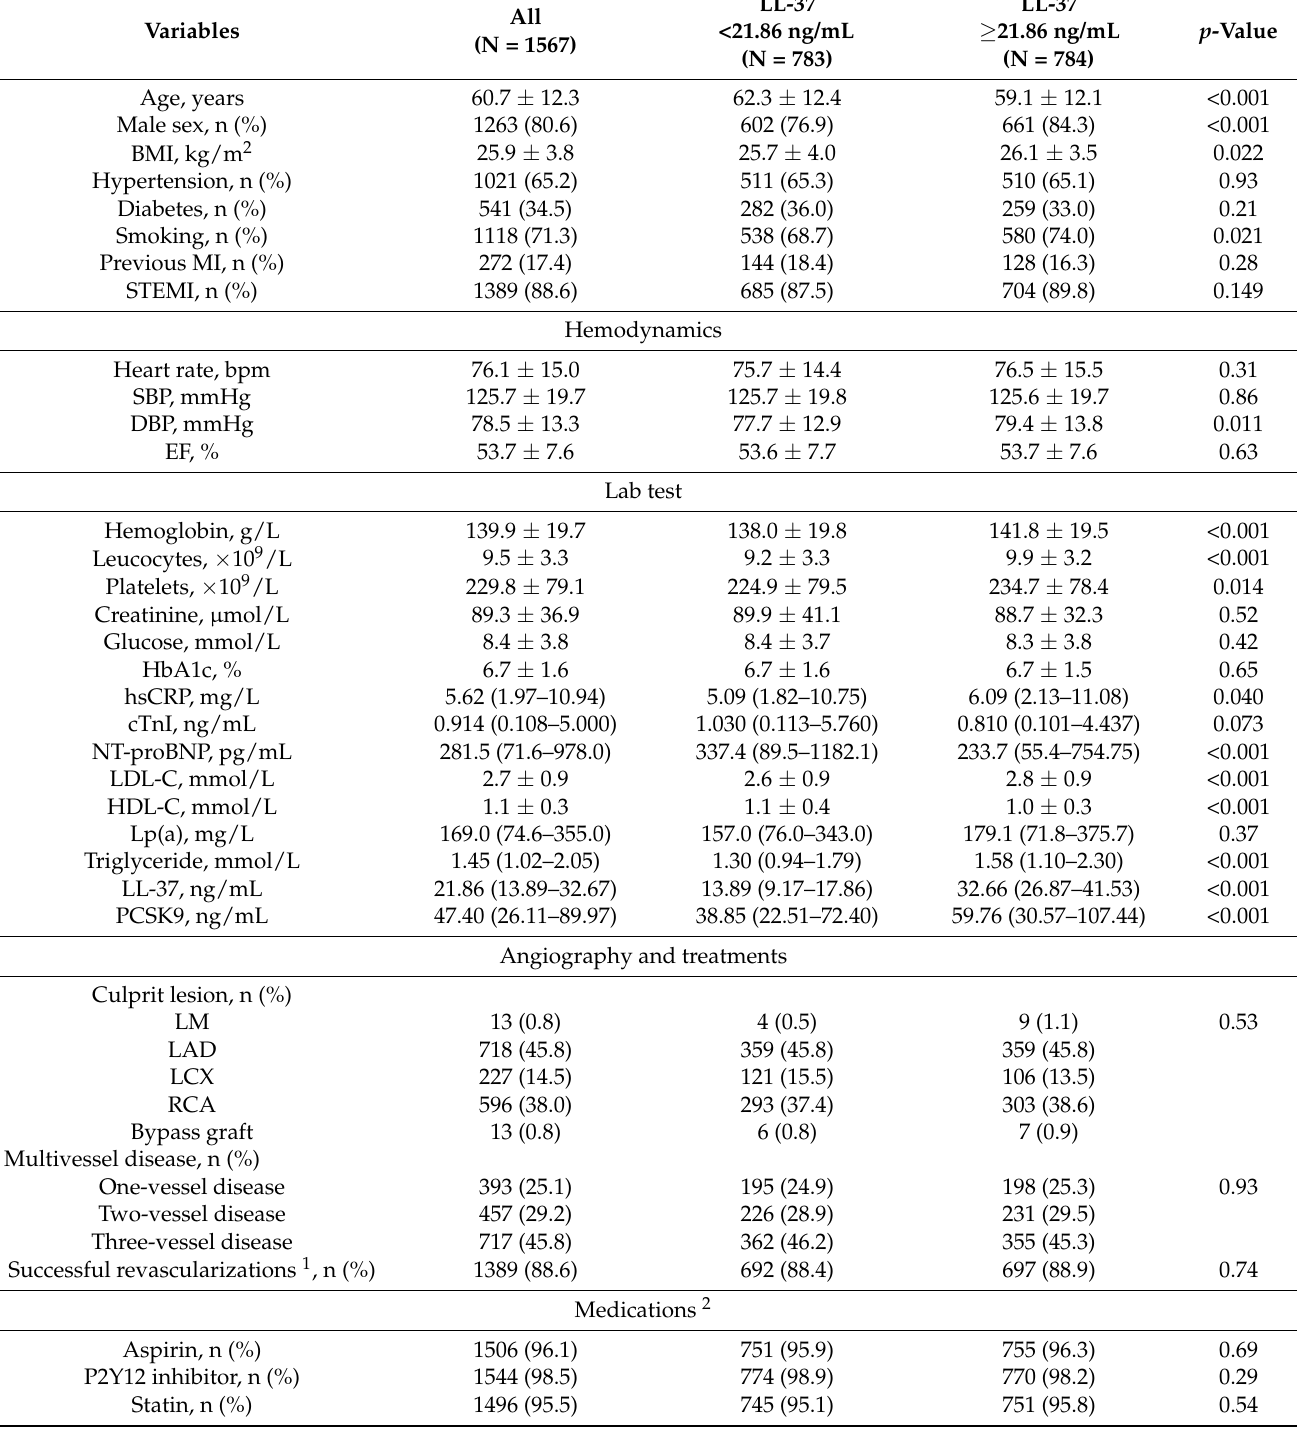
Table 1. Baseline characteristics stratified by median level of